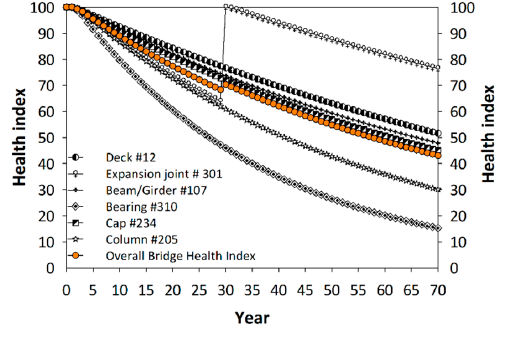
Figure 9. Non-NHS bridge performance in Virginia. ( a ) Overall bridge; ( b ) concrete deck; ( c ) expansion joint; ( d ) bearing.